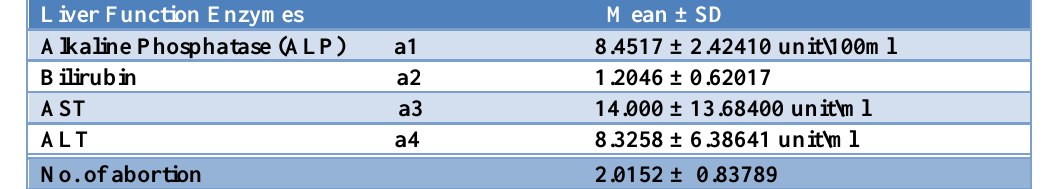
Table, 1: Level of Liver function tests in infected women with Toxoplasmoa gondii in different No. of abortions Liver Function Enzymes